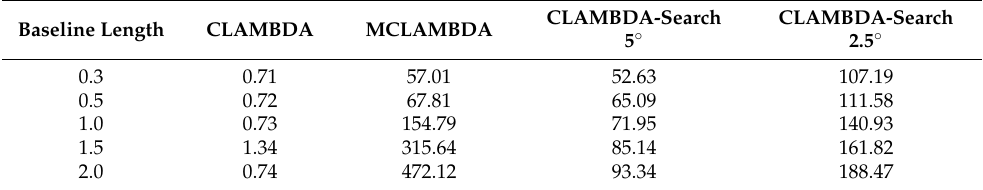
Table 6. Calculation time [ms] for each test in the degraded environment.